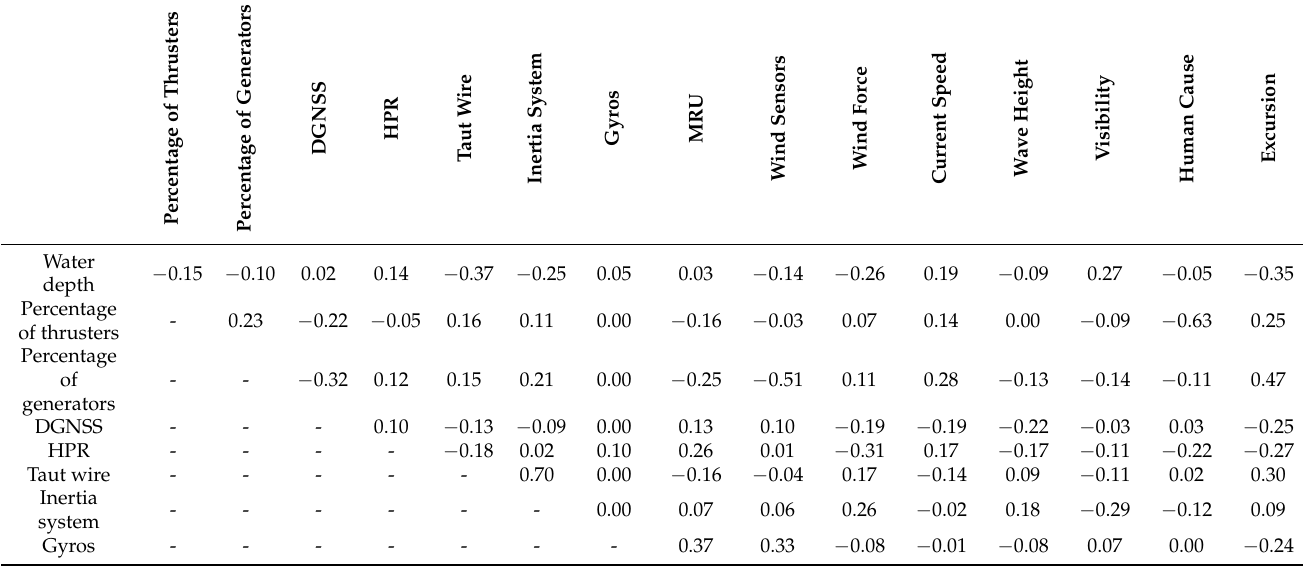
Table A1. Correlation coefficients (n =